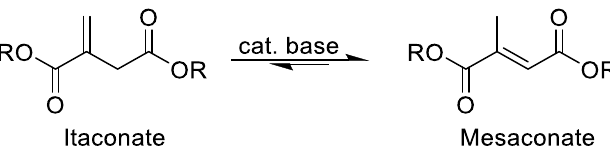
Figure 2. 1 H NMR spectra of PEA-103.